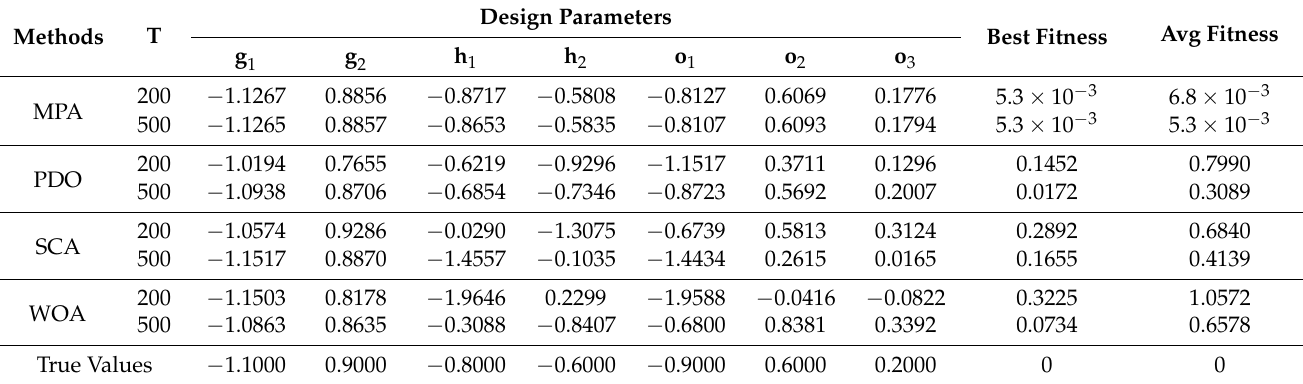
Table 9. Estimated weight analysis w.r.t generations at a 0.10 noise level for case study